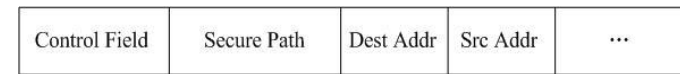
Figure 3. The structure of the notification